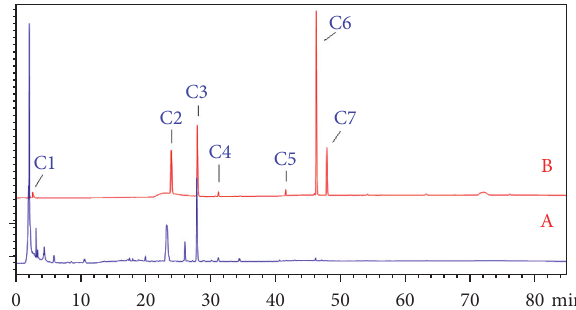
Figure 1: The HPLC chromatogram of samples and standard